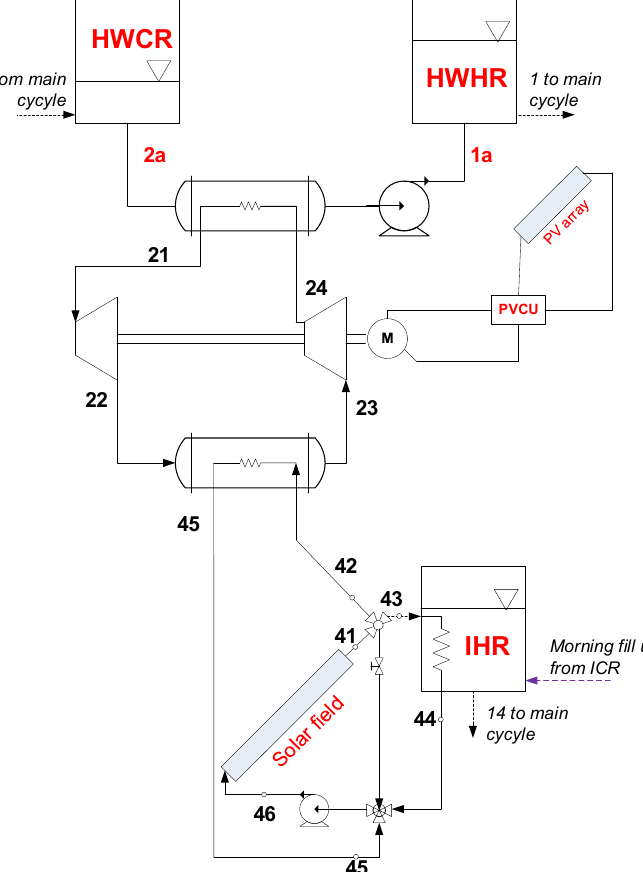
Figure 1. Solar-assisted heat pump cycle–schematic.